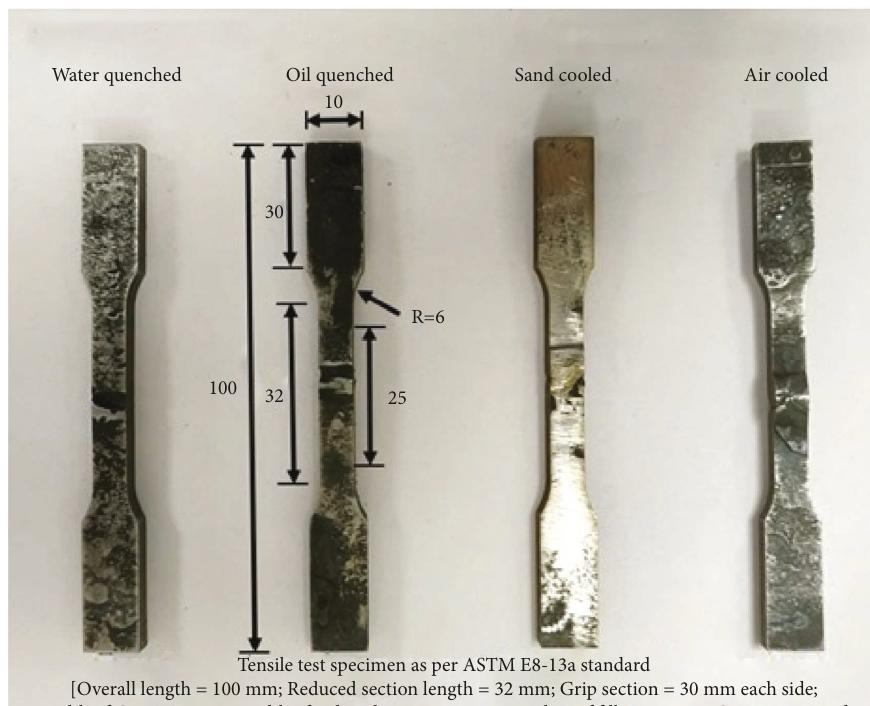
Figure 2: Tensile test specimens as per ASTM E-8M standard.